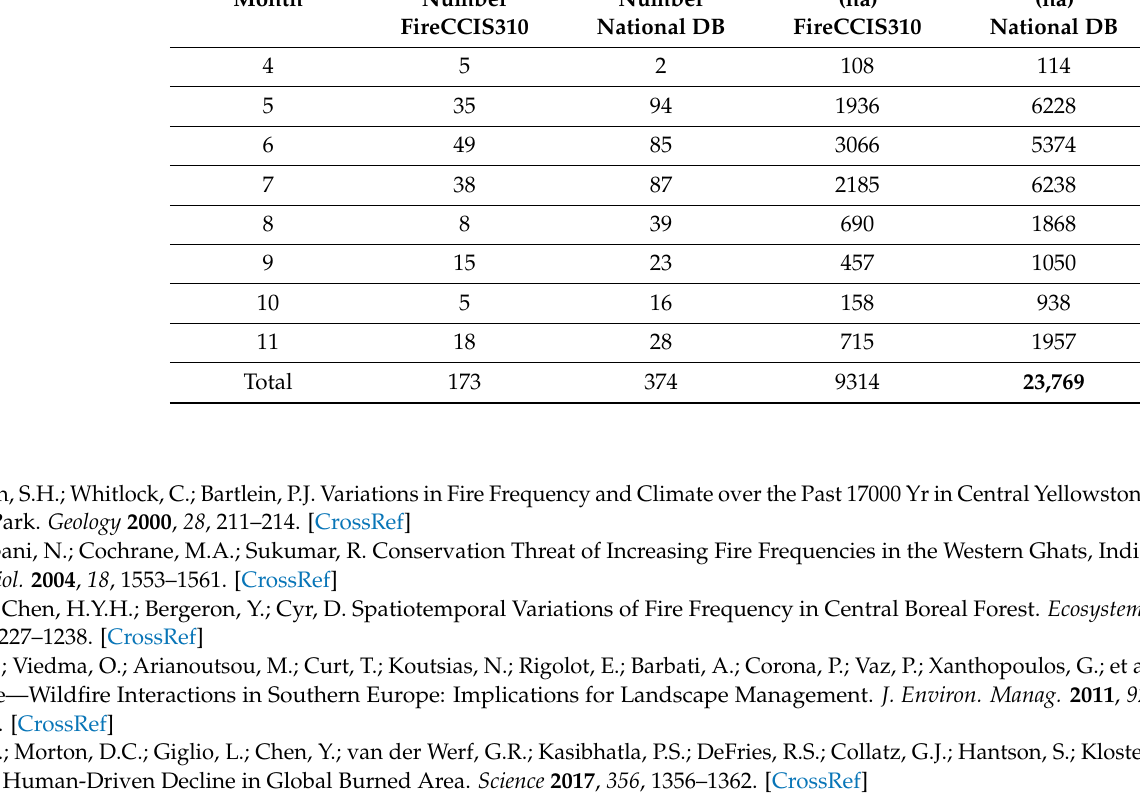
Figure A2. Example of a fixed spatial inaccuracy. ( a )—the original mapping from the INPA database; ( b – e ) fixed mapping. ( b )—11 May 2018; ( c )—21 May 2018; ( d )—26 May 2018; ( e )—31 May 2018. (The dates indicate the date of the first sentinel-2 imagery (shown in a false color composite) in which the wildfire scar was detected.)